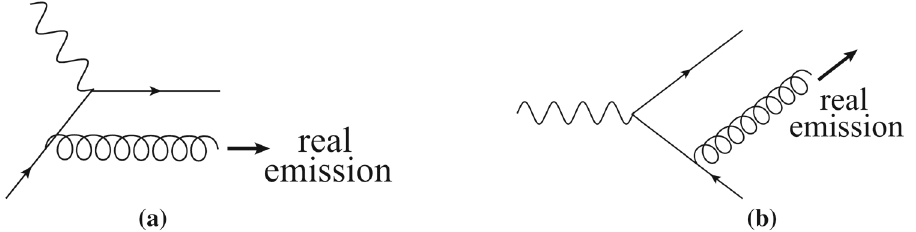
line corresponds to the fragmenting quark associated to the collinear part representing the final hadron, while the radiated gluon is the hard real